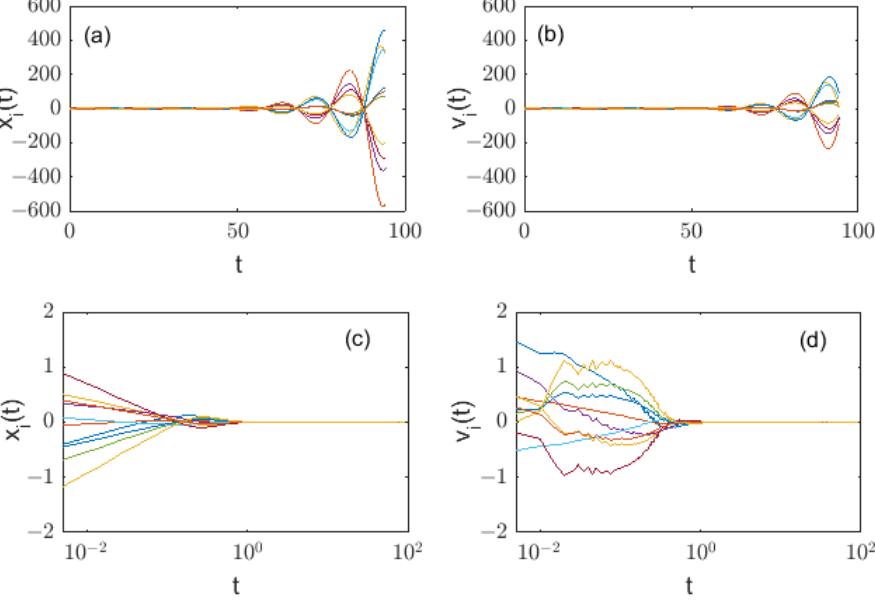
Figure 15. The curves of the position and velocity of each agent as a function of time of FOMAS (2) in the absence of noise ( a , b ) and in the presence of noise ( c , d ) ( 𝑝 = 0.6 ).